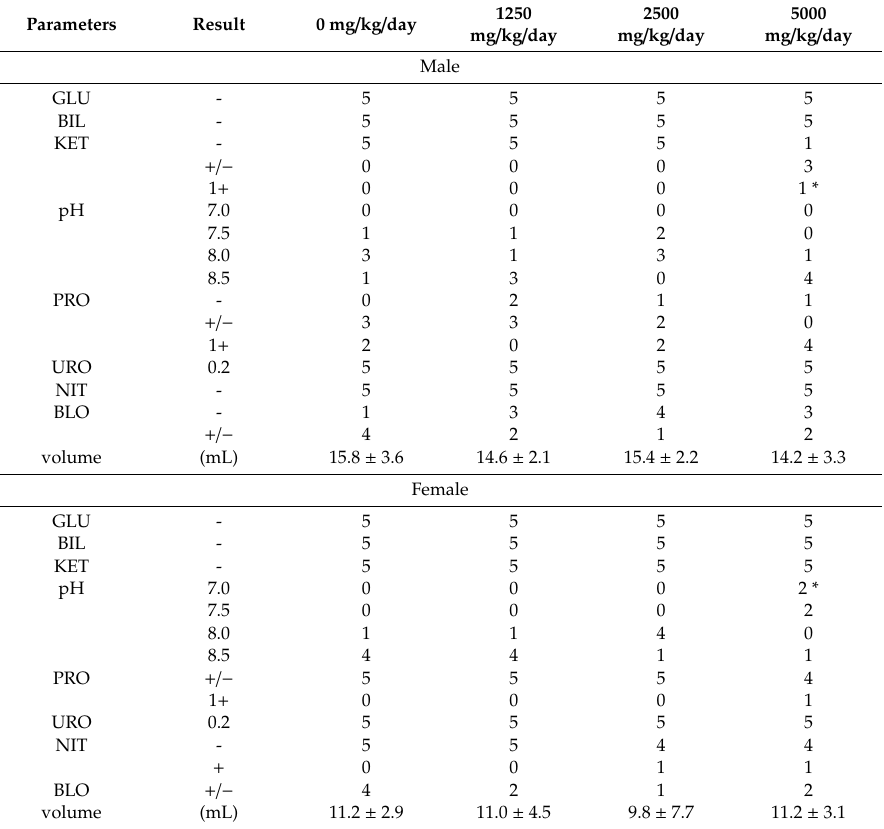
Table 2. Urinalysis data of SD rats orally administered frpfdZAL for 13